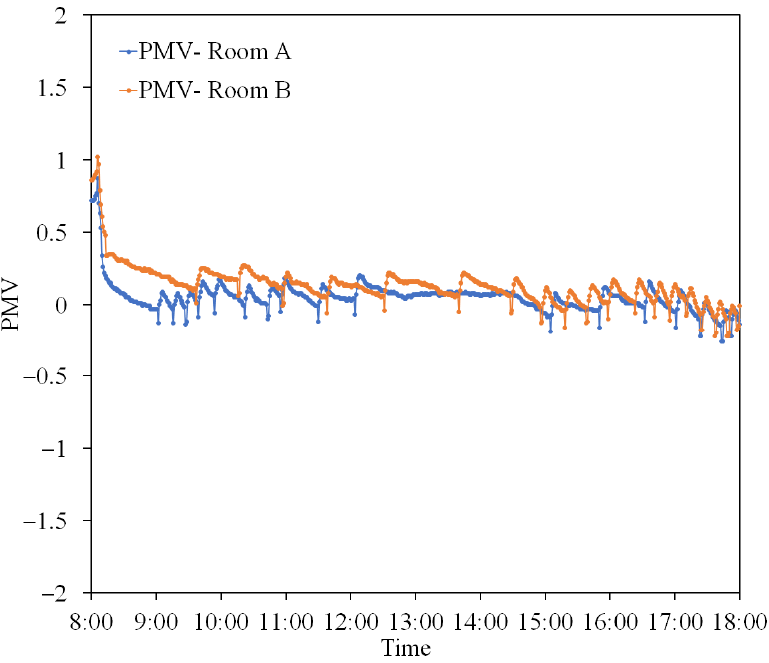
Figure 12. PMV value on June